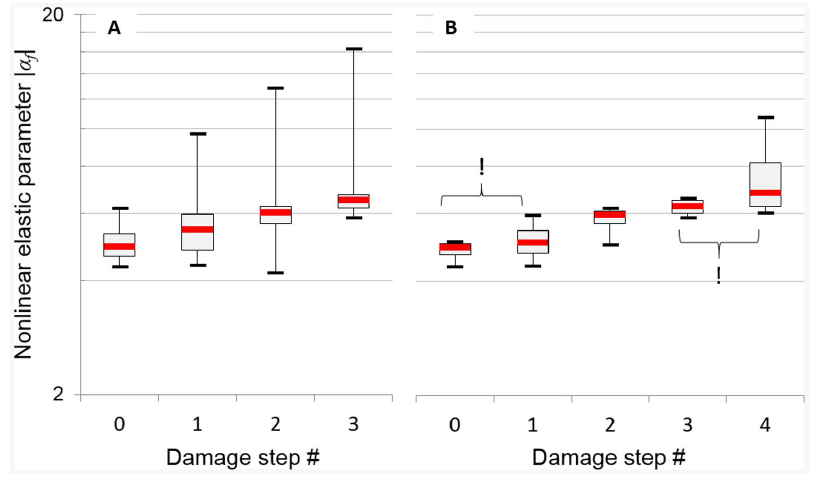
Figure 4. Box plot of the nonlinear elastic parameter a f after each damage step. (A) Group 1 (N=8) specimens having undergone the first three stages of damage; (B) Group 2 (N=4) specimens having undergone the four damage steps. (!) means no significant effect of fatigue on parameter a f between two steps (p . 0.05).